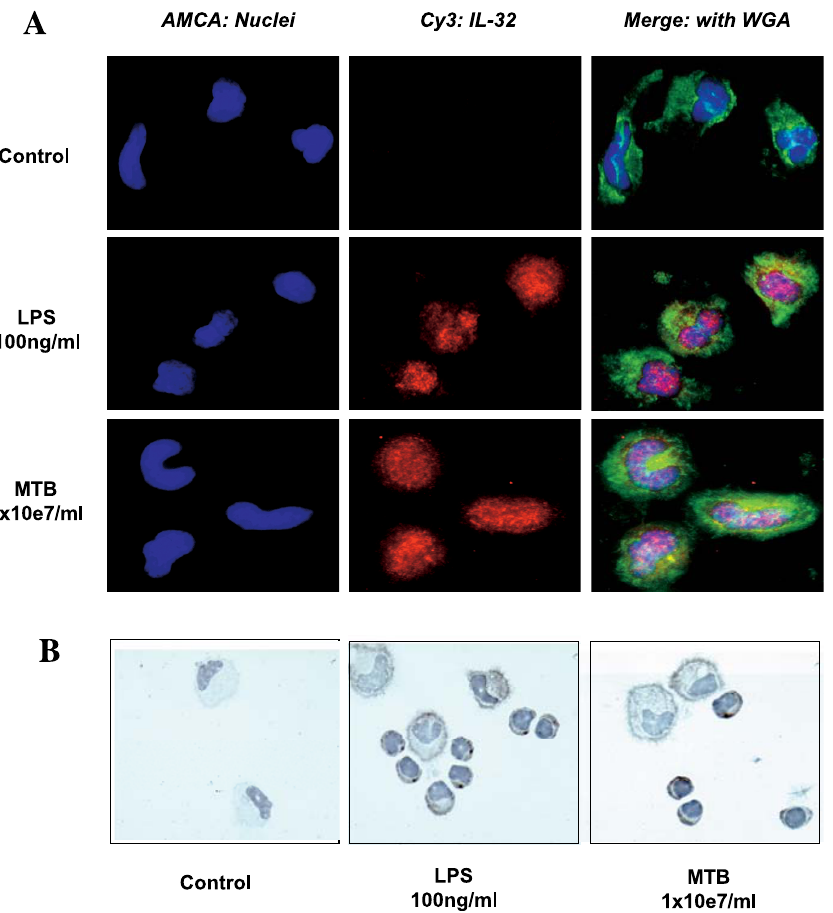
Figure 3. IL-32 Immunostaining of Human PBMCs Stimulated with LPS or M. tuberculosis (A) Freshly isolated PBMCs were left to adhere, stimulated with either control medium (first row), LPS (second row), or M. tuberculosis (MTB; third row), and 24 h later stained for the presence of IL-32. Nuclei were stained with AMCA (blue, left panels), and IL-32 was stained with Cy3 (red, middle panels). The right panels show the merged pictures with WGA-stained cellular surface (green).The stained cells were examined by digital deconvoluted microscopy. (B) PBMCs stimulated with control medium (left panel), LPS (middle panel), or M. tuberculosis (right panel) were stained with an anti-IL-32 monoclonal antibody and counterstained with Mayer’s hematoxylin for optical microscopy. DOI: